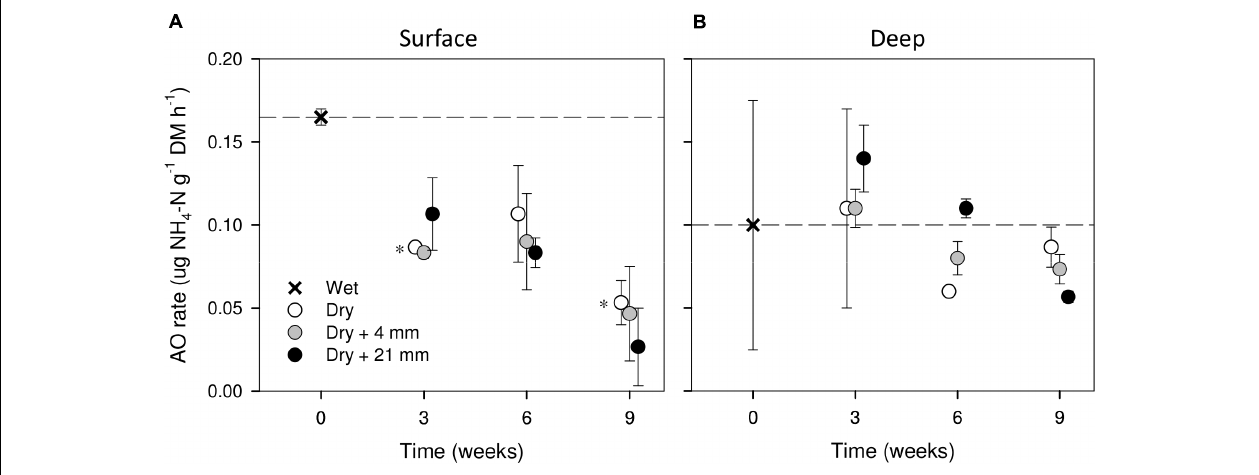
FIGURE 3 | AO rates in surface (A) and deep (B) sediments during initial conditions (0 weeks) and after the different RMs for each DPD. Asterisks ( ∗ ) denote significant ( P ≤ 0.05) differences to initial wet conditions after Student’s t -test followed by Holm’s correction for multiple comparisons. Values are means ± SE ( n = 3). The dashed line represents the initial conditions as a reference for a better